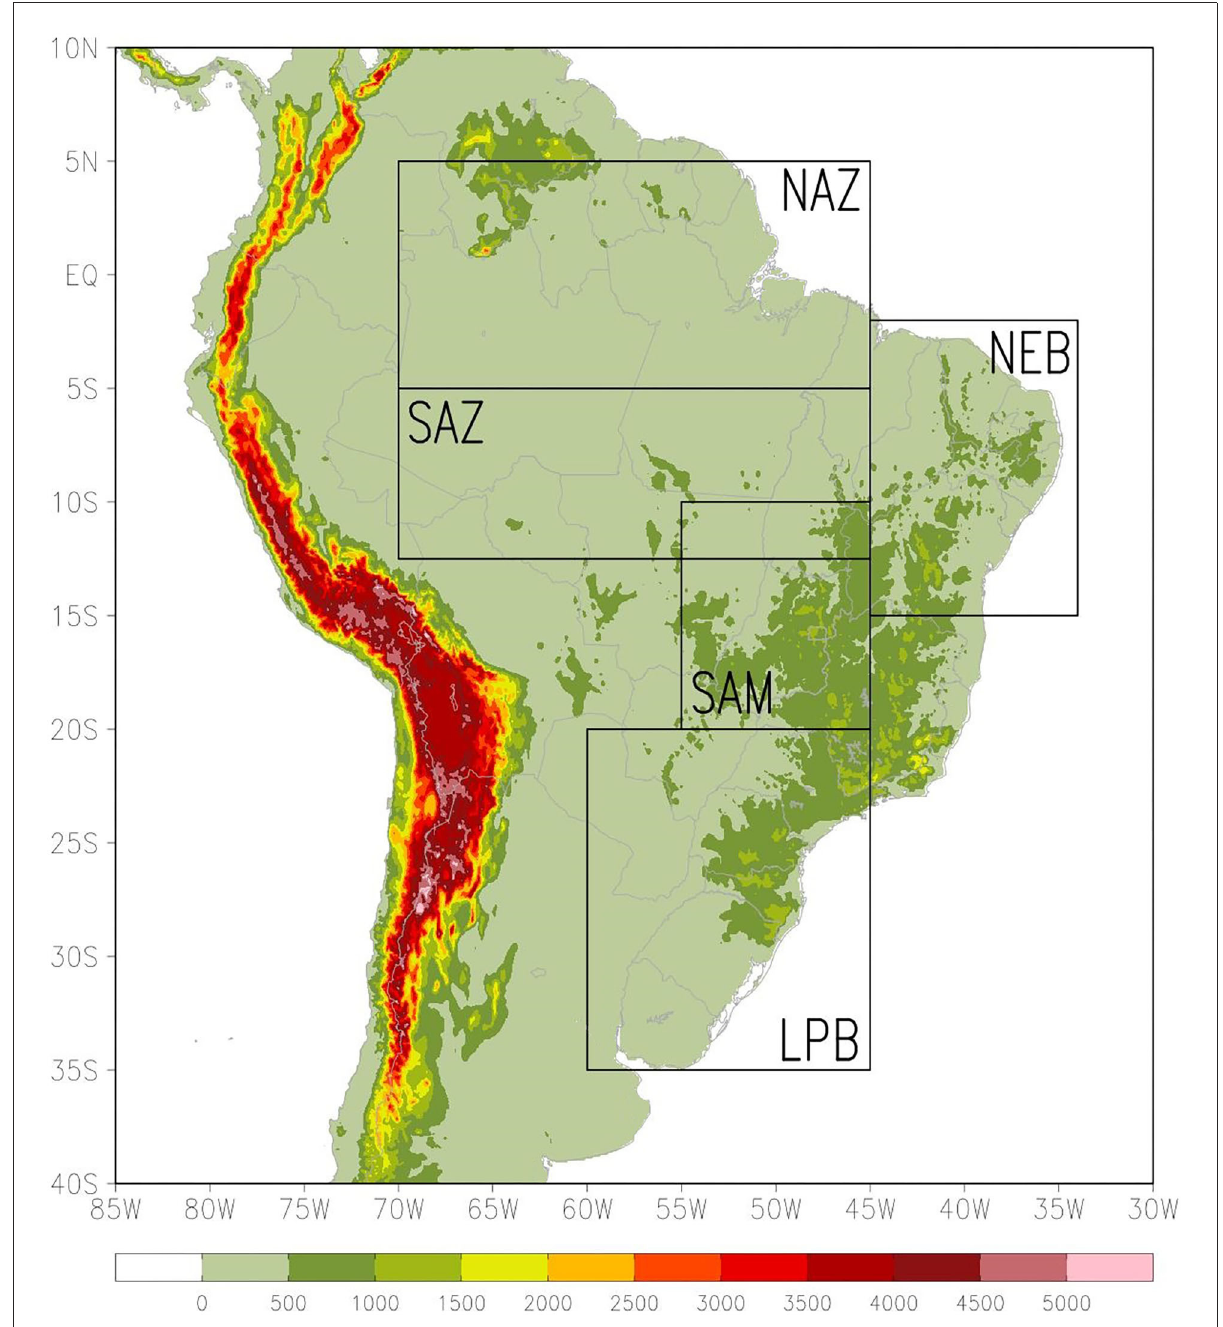
FIGURE1 Topography of the study area (m; shaded) with the sub-regions delimited: Northern Amazon (NAZ; 5 ◦ S − 5 ◦ N, 70 ◦ -45 ◦ W), Southern Amazon (SAZ; 12,5 ◦ -5 ◦ S, 70 ◦ -45 ◦ W), Northeast Brazil (NEB; 15 ◦ -12 ◦ S, 45 ◦ -34W), South America Monsoon (SAM; 20 ◦ -10 ◦ S, 55 ◦ -45 ◦ W) and La Plata Basin (LPB; 35 ◦ -20 ◦ S, 65 ◦ -45 ◦